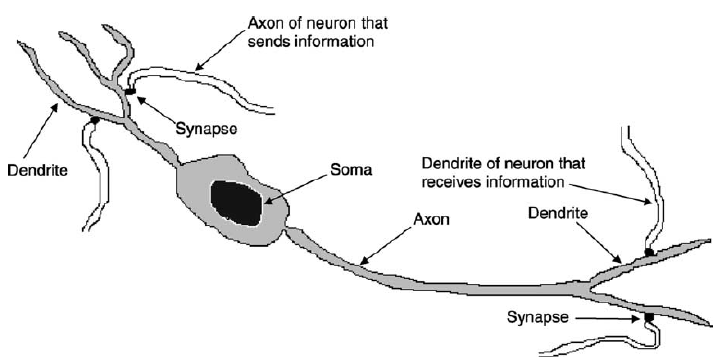
Figure 8. Biological neuron [162].